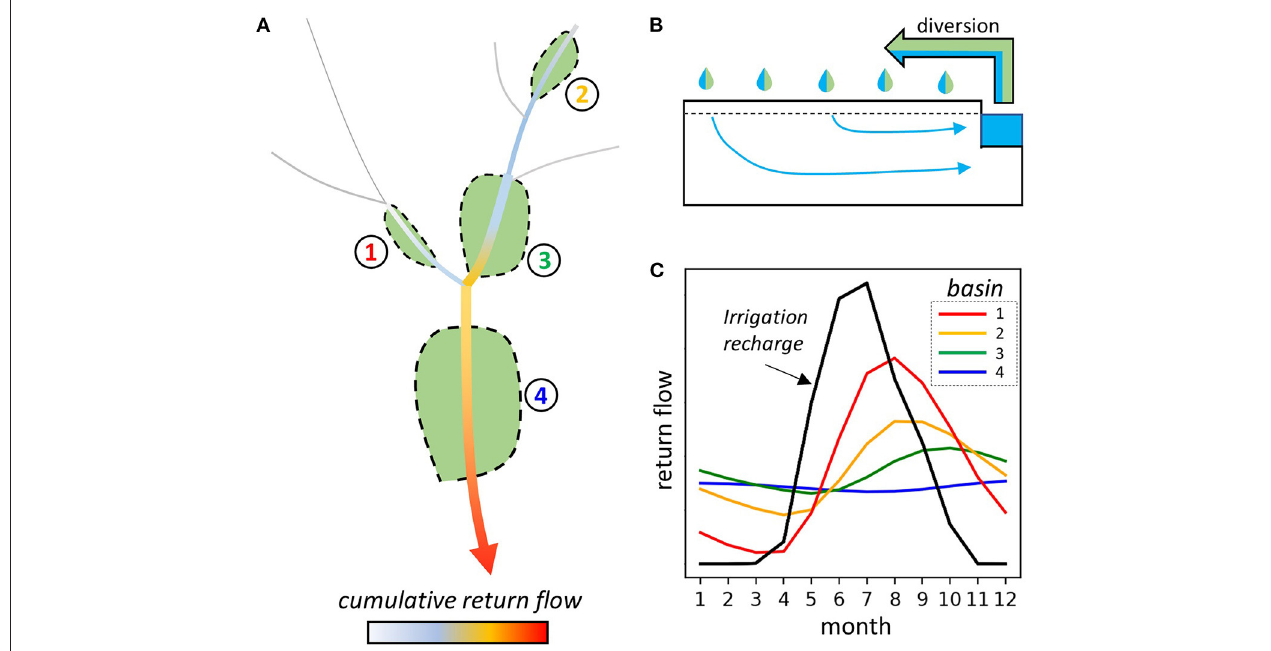
FIGURE 1 | Return flows increase downstream with individual alluvial valleys contributing from lower to higher stream orders within a watershed (A) . Irrigation efficiency controls how much diverted water shown by the arrow in (B) becomes recharge (blue fraction). Return flow timing and magnitude is controlled by local basin properties that affect the attenuation and delay of return flow discharge (C)